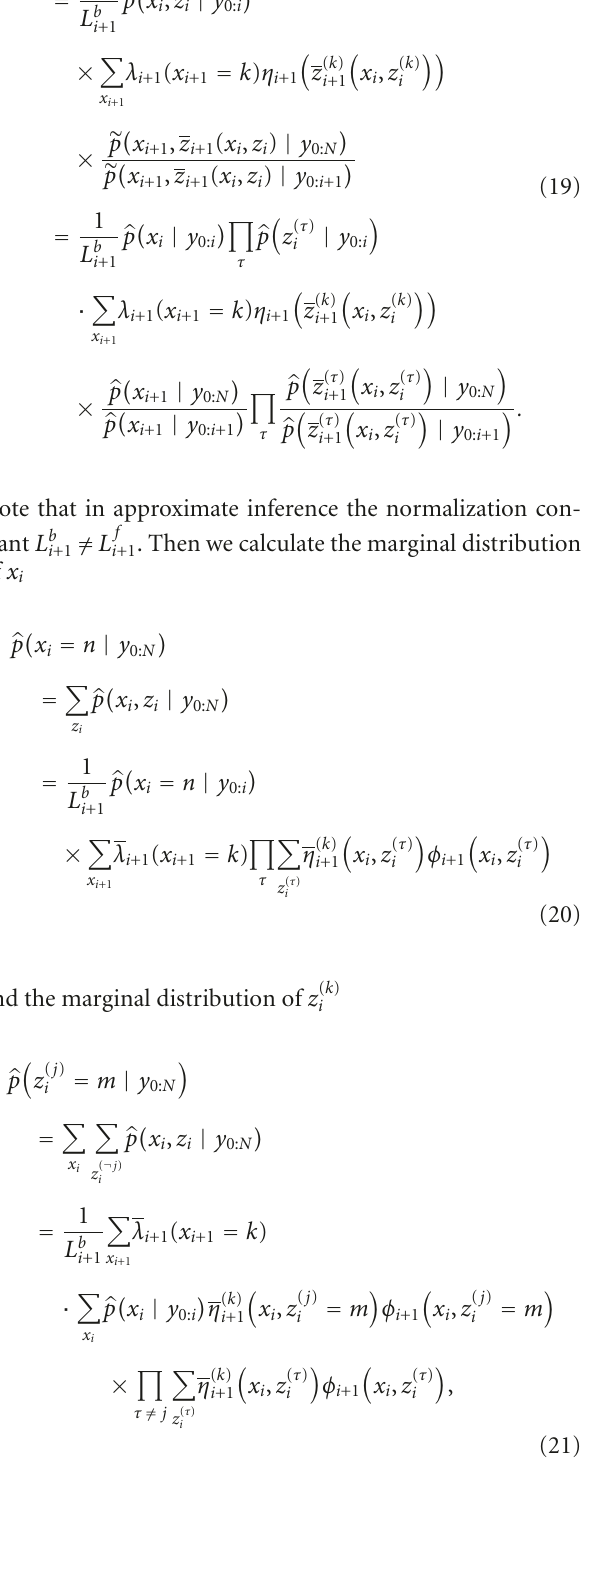
Figure 5: The EM framework. The inference module is imple- mented with the algorithms presented in Sections 4 and 5, and the parameter estimation module is implemented with